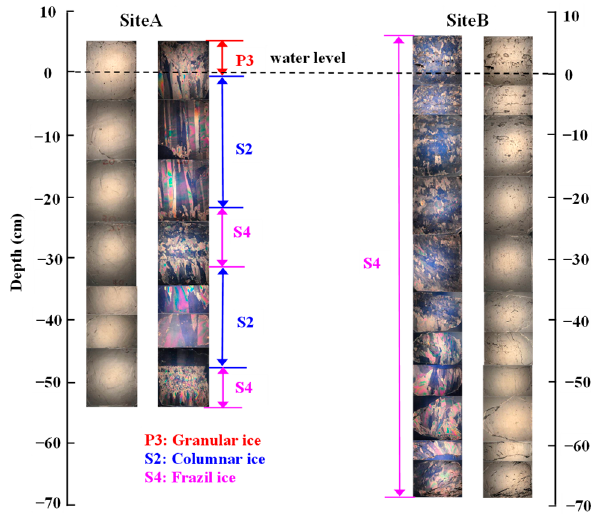
Figure 5. Vertical thin sections of ice cores under natural and polarized light collected on 15 February 2014 at Site A and Site B. The origin on the y-axis corresponds with the water level.